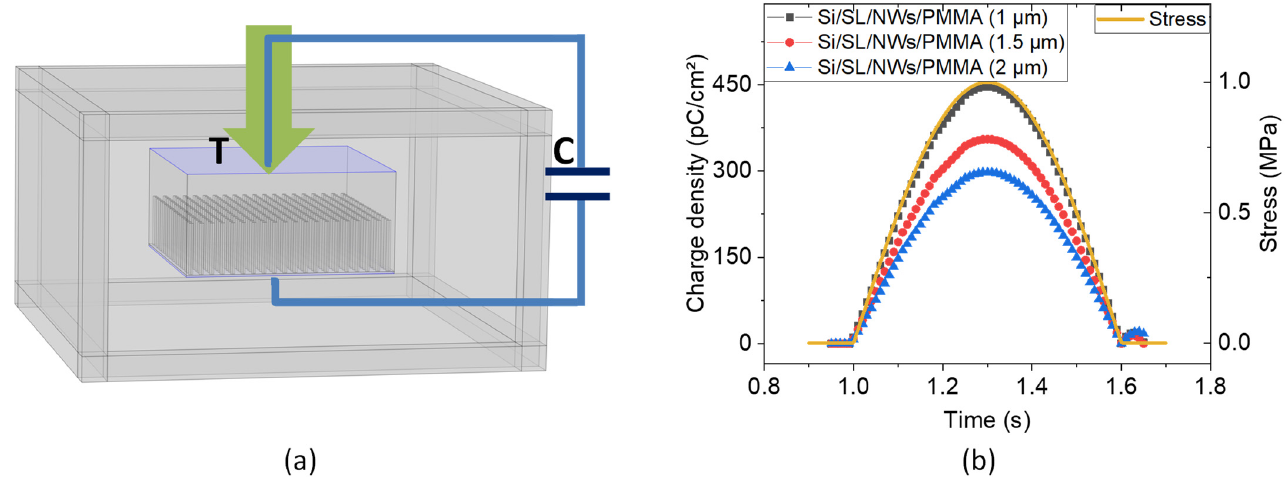
Figure 17. FEM simulation performed using the “Piezoelectricity module” coupled with “Electrical circuit module”; ( a ) schematics of the ZnO NW composite, in parallel with an external capacitor of 100 nF subjected to a compressive stress of 1 MPa magnitude; ( b ) theoretical piezoelectric response of different NWs/PMMA composite with respect to the PMMA thickness.